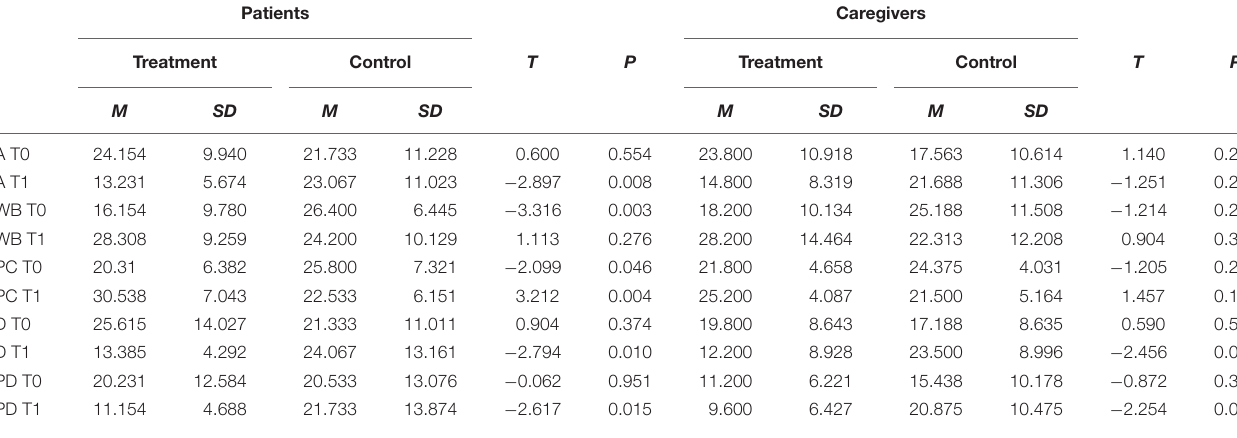
TABLE 2 | T -Test comparisons between the treatment and control groups of patients and caregivers at T0 and T1. Patients Caregivers